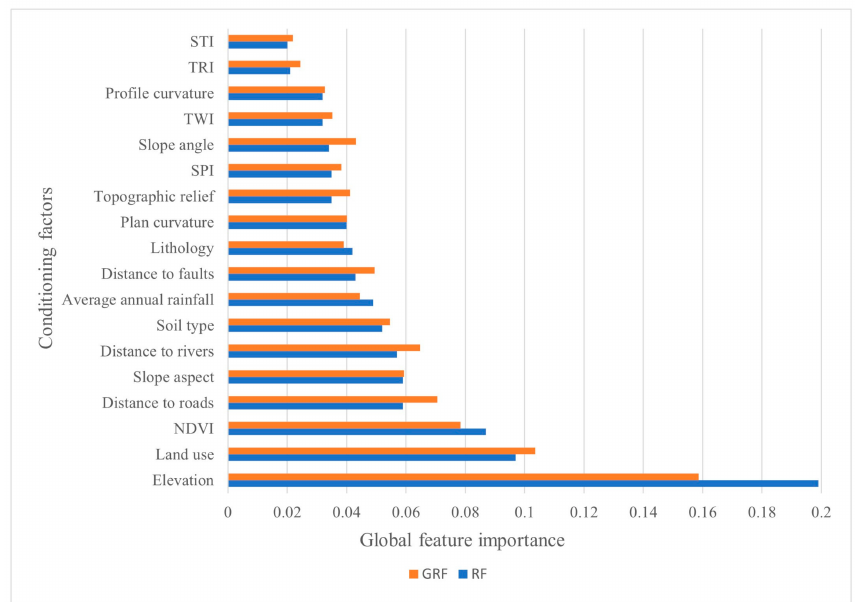
Figure 5. Global feature importance of RF and GRF.